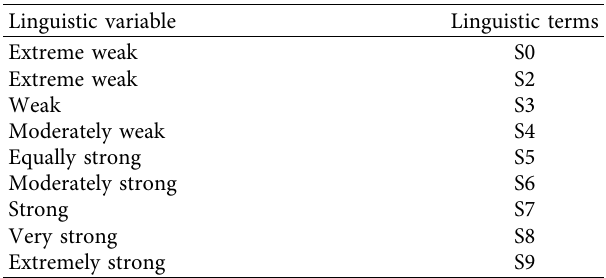
Table 7: Linguistic terms corresponding to linguistic variables for pairwise comparisons.